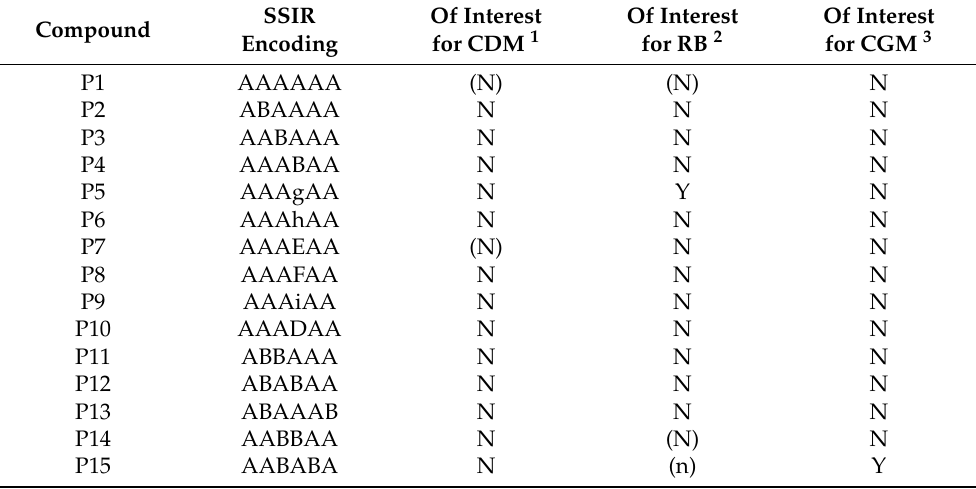
Table 1. Molecular encodings with the qualitative activity as fungicide against three